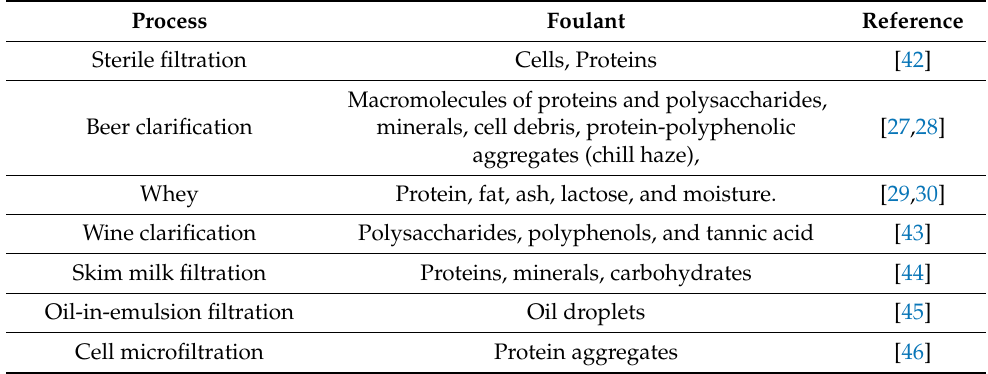
Table 5. Common foulants in microfiltration applications and related references.